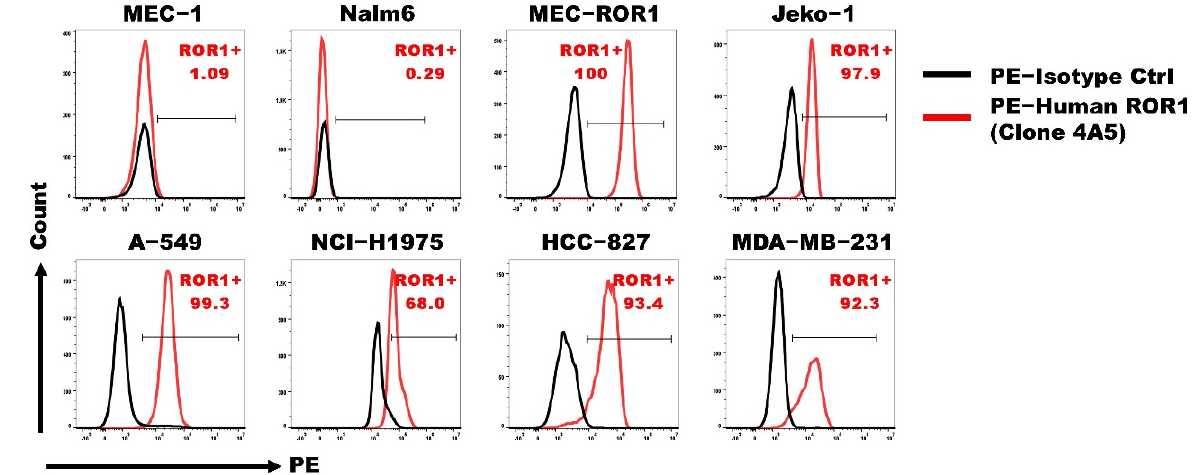
Figure 1. Various human cancer cell lines that expressed the ROR1 antigen. Lung cancer cell line A549, HCC827, H1975, breast cancer cell line MB-MDA-231, and mantle cell lymphoma cell line Jeko-1 were stained with anti-ROR1 antibody (clone 4A5) or isotype control and analyzed by flow cytometry. B-chronic lymphocytic leukemia cell line MEC-1 and B-acute lymphocytic leukemia cell line Nalm 6 served as negative controls, whereas MEC-1 that was transduced to express the ROR1 antigen (MEC-ROR1) served as a positive control. The black solid line represents an isotype control, while the red solid line represents the antibody staining.